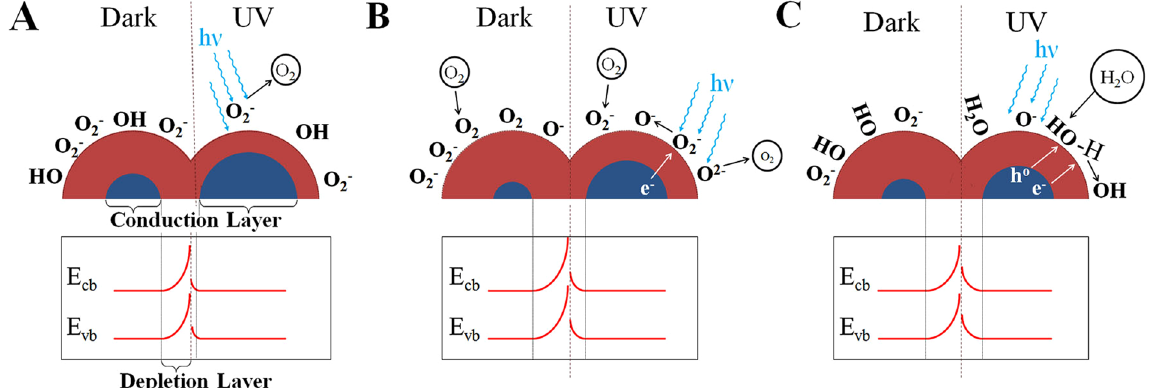
Figure 1. Schematics of the conduction (grain) and depletion (grain boundary) regions of ZnO illustrates the changes in valence (E vb ) and conduction (E cb ) band structure of ZnO nanoparticles between dark and UV conditions while under vacuum ( A ), with exposure to oxygen gas ( B ), and with exposure to water vapor ( C